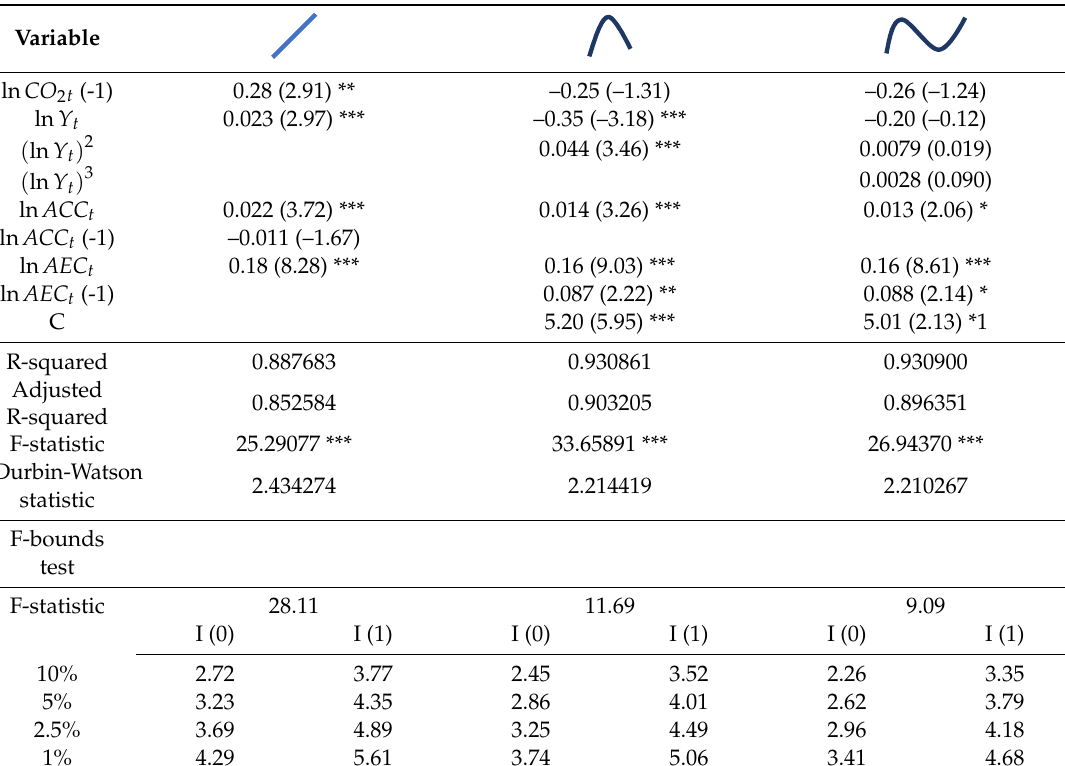
Table 6. Bounds test and short ‐ run relationship. Table 7. Error correction model and long ‐ run relationship. Table 9. Residual diagnostic tests.